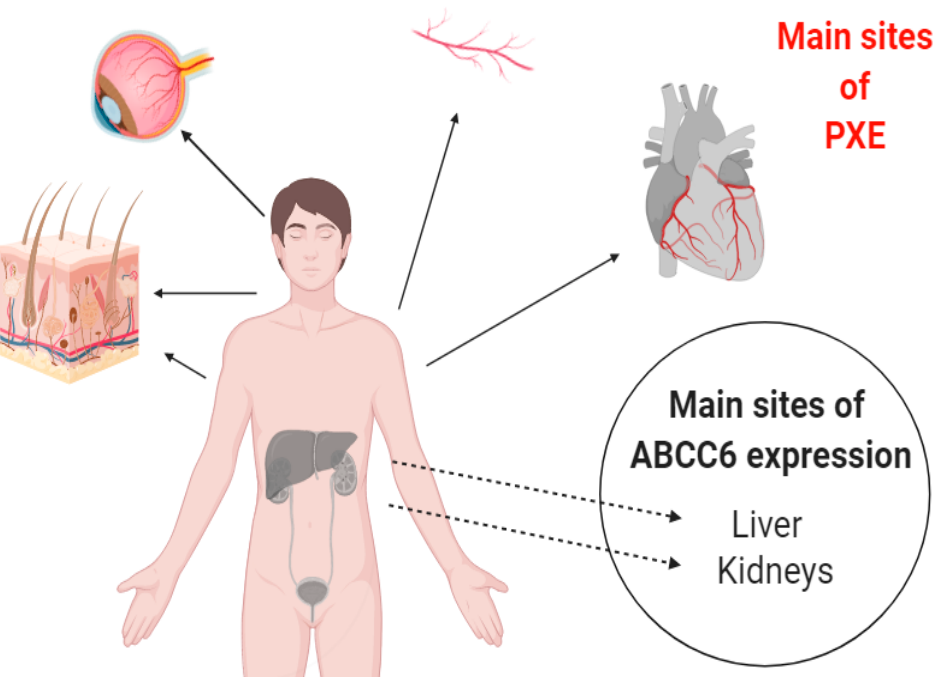
Figure 1. Pictorial presentation of ABCC6 expression and affected tissues in Pseudoxanthoma elasticum (PXE). The protein is expressed mainly in liver and kidney cells but the main areas in- volved in ectopic calcification are the elastic tissues of heart, blood vessels, skin, and